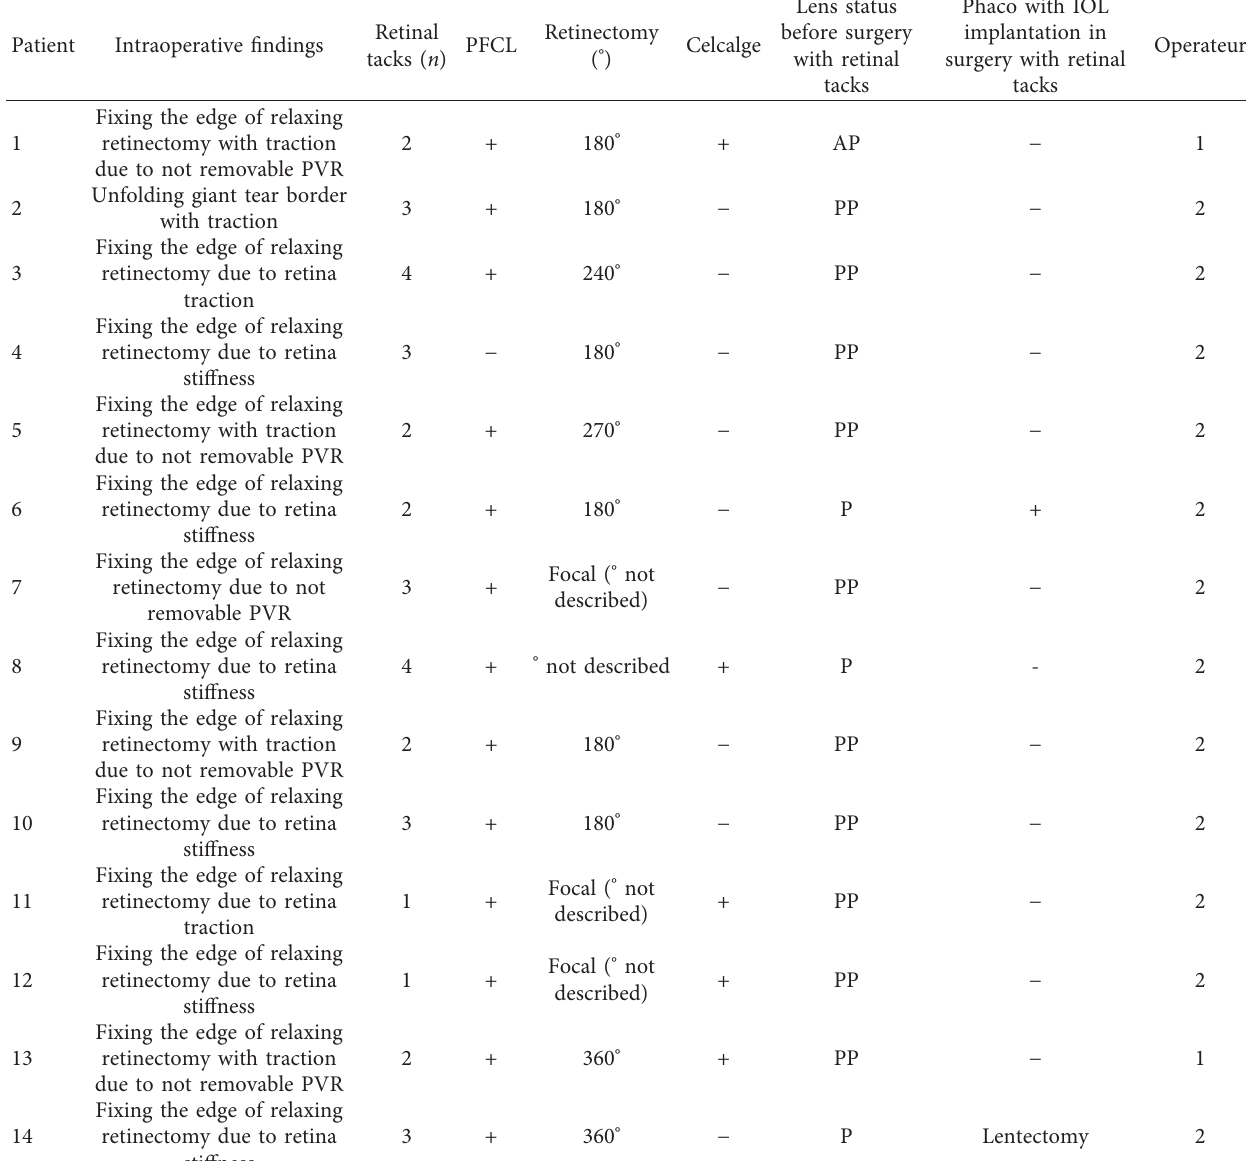
Table 3: Indications and surgical